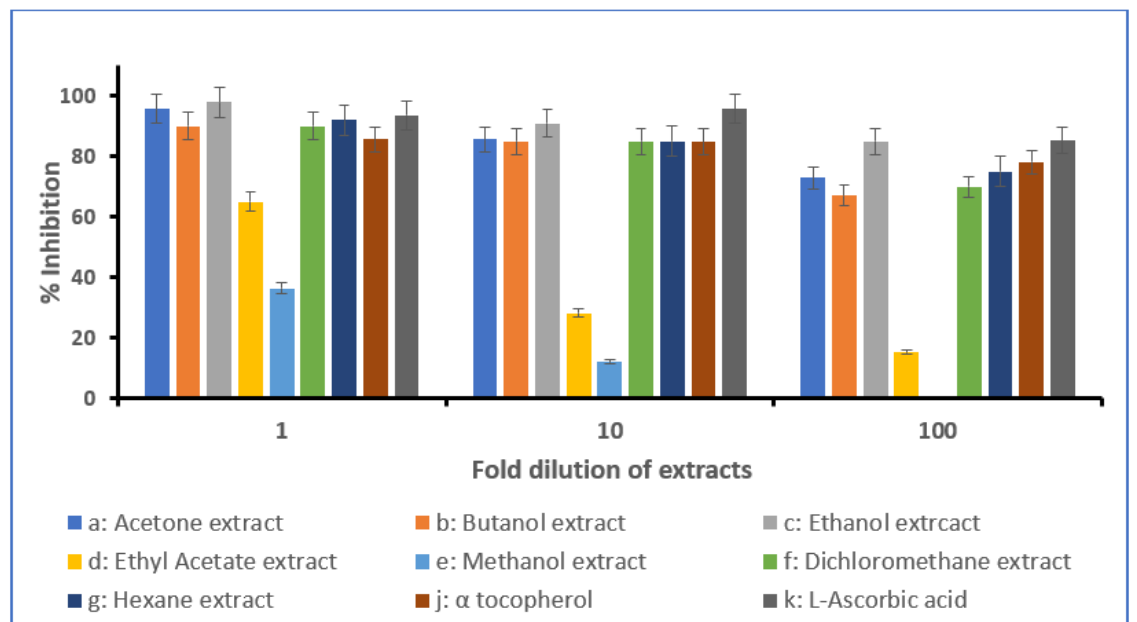
Figure 2. Antioxidant activity of the Aerva javanica extracts by the DPPH method. Various extracts